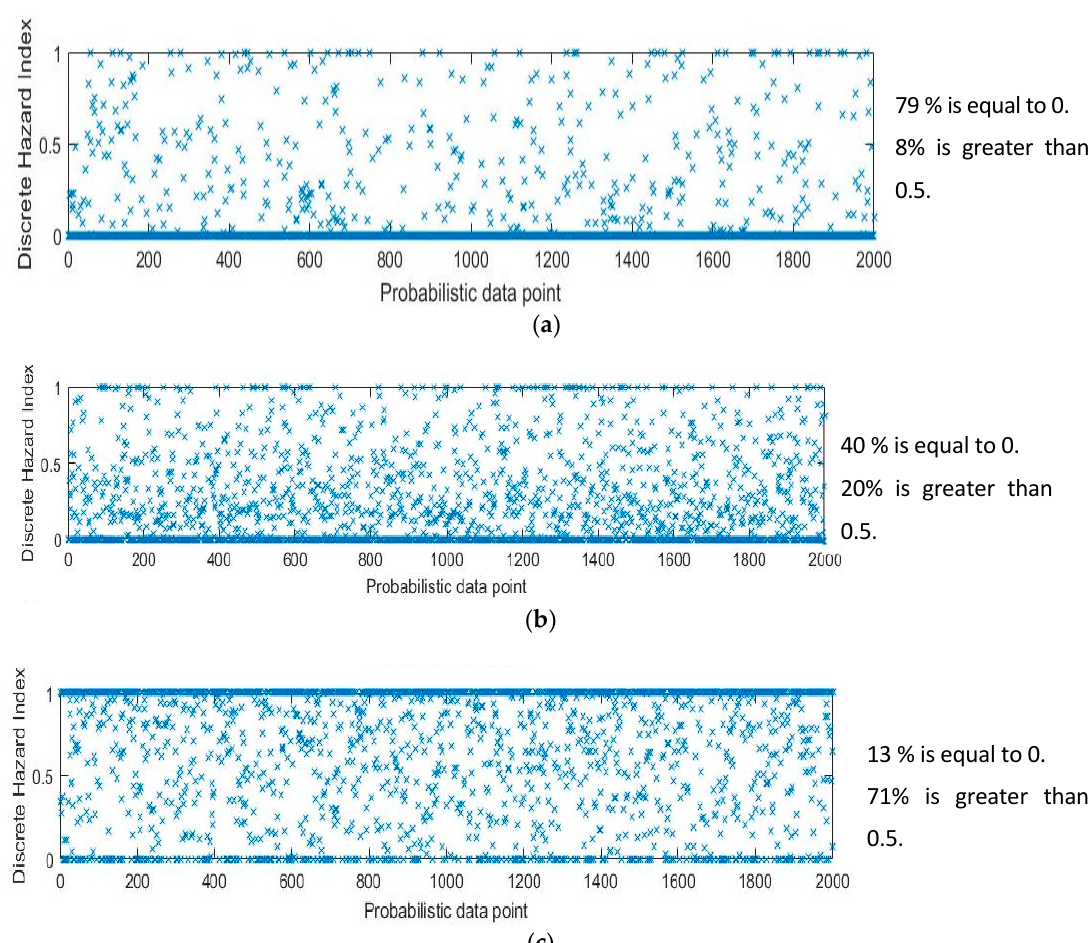
Figure 9. Detailed assessment of each of the evaluations. ( a ) 2D evaluation of a point (3.28, 0.37) outside the hazard zone (corresponding to Figure 8a); ( b ) 2D Evaluation of a point (5.76, 2.73) in the transition zone (corresponding to Figure 8b); ( c ) 2D Evaluation of a point (2.83, 2.77) inside the hazard zone (corresponding to Figure 8c).